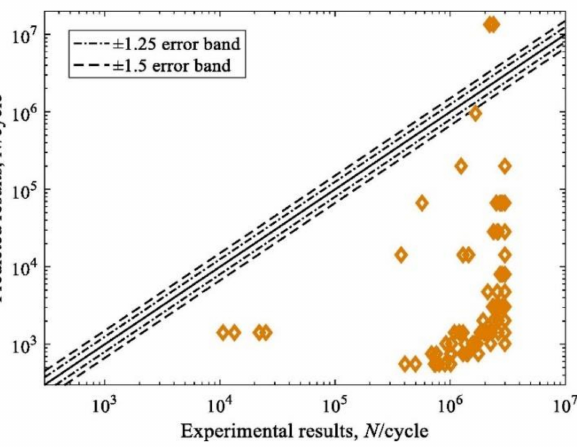
Figure 32. Comparison between CDM-based predicted results and experimental results. Reprinted with permission from ref. [88]. 2021,